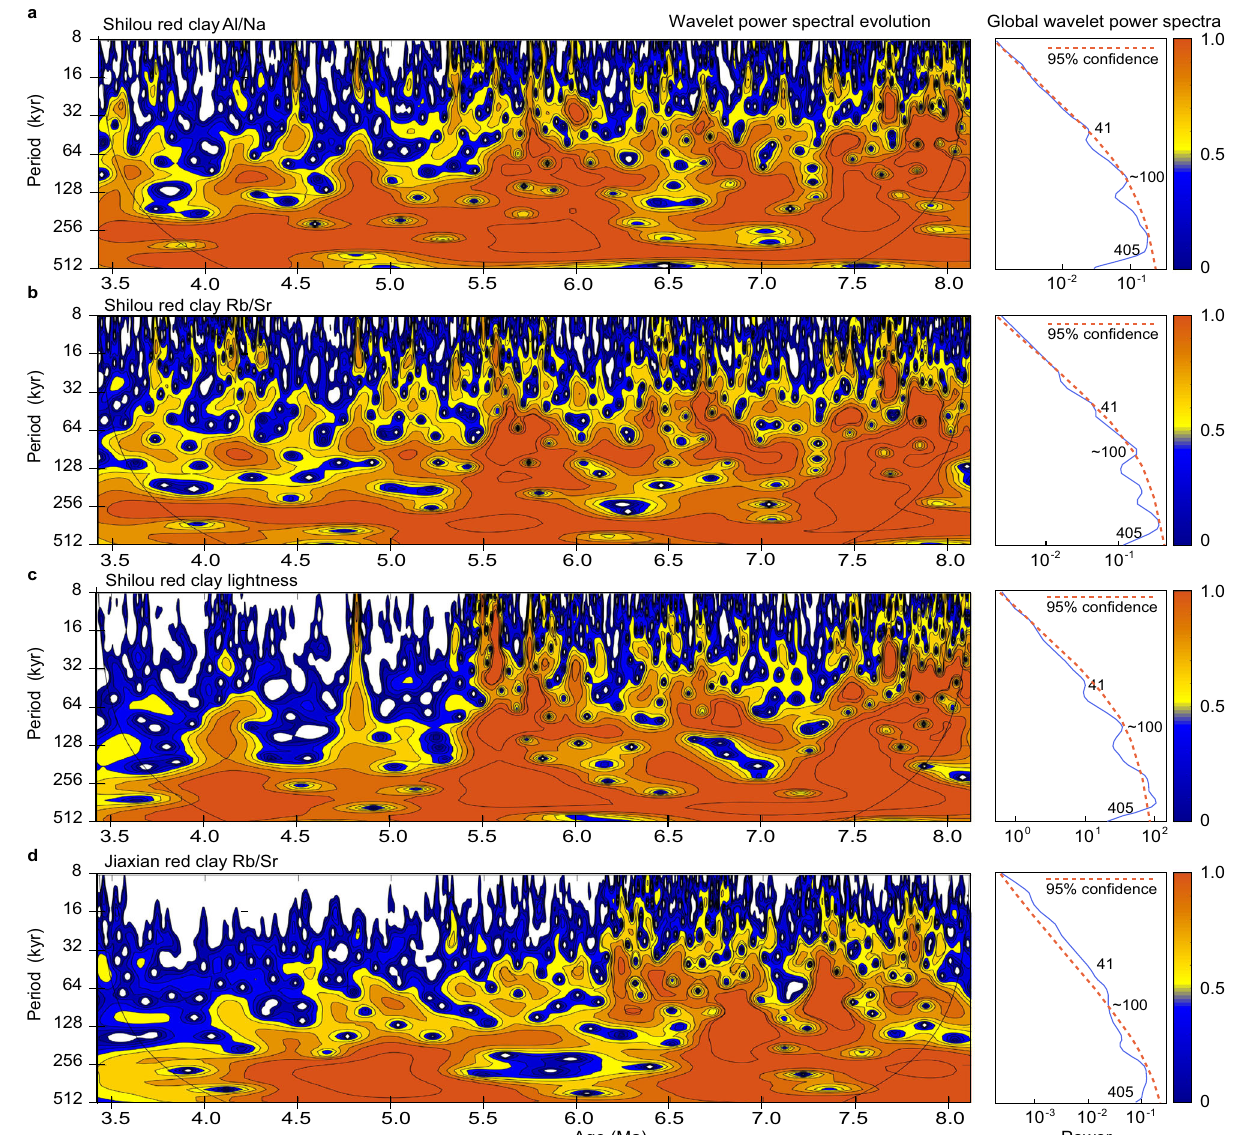
Fig. 3 Orbital variability of Chinese Loess Plateau Asian summer monsoon records. Wavelet power spectral evolution and global wavelet power spectra for a Al/Na, b Rb/Sr, and c lightness records from the Shilou red clay section, and d Rb/Sr record from the Jiaxian red clay section 26